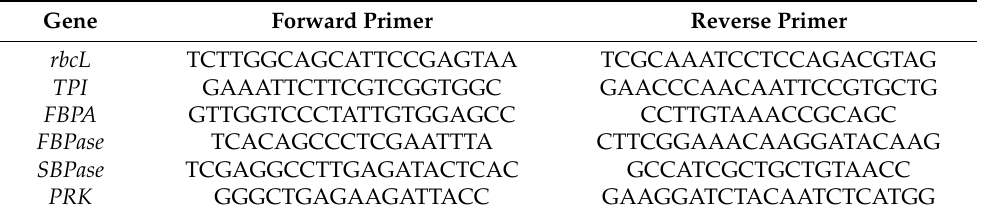
Table 1. Gene-specific primers designed for qRT-PCR.